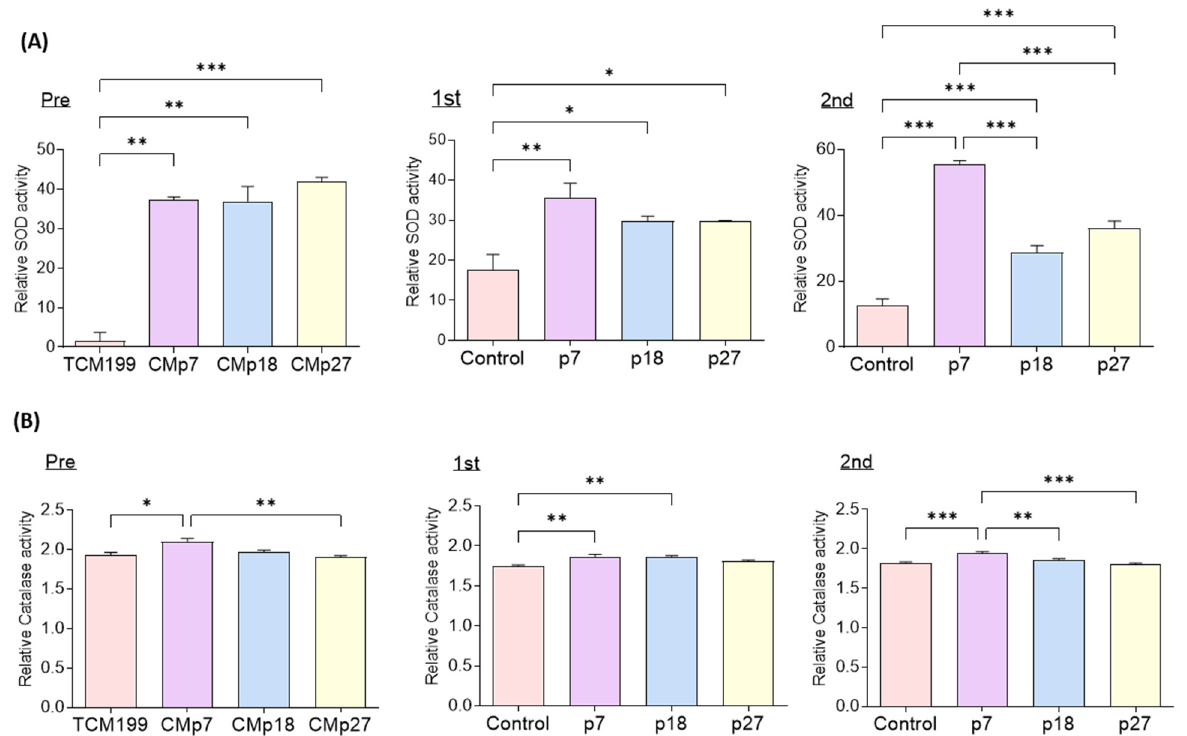
Figure 5. Evaluation of the SOD and catalase activity from IVM medium supernatant in comparison to the control and supplementation with different passage of eAFMSC-CM. ( A ) Superoxide dismutase (SOD) and ( B ) catalase activity. Pre; TCM199 (IVM medium) and Fresh CM. First; Medium after 22 h of IVM. 2nd; Medium after 44 h of IVM. The asterisks represent significantly different when compared to the control (*: p < 0.05, **: p < 0.01, ***: p < 0.001).